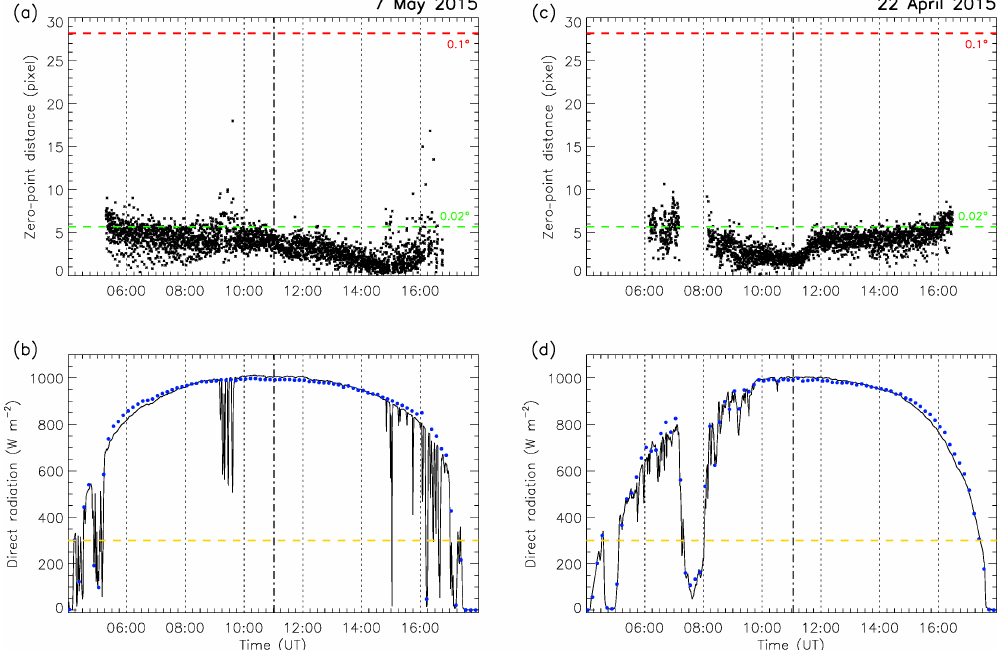
Figure 6. Performance of the Sun-tracking device at the Kanzelhöhe Observatory ARAD site for days with nearly continuous clear sky (7 May 2015, left column) and clear sky interrupted by frontal movement (22 April 2015, right column): (a) radial distance from the zero point of each valid image (asterisks); (b) direct radiation (1min averages) derived from the Kanzelhöhe Observatory ARAD site (line) and from actual Sun-sensor measurements of the Sun-tracking device (in 10min intervals, blue dots) on 7 May 2015. (c–d) As panels a–b but for 22 April 2015. Limits of active tracking (i.e., alignment within 0.02 ◦ accuracy, green line) and passive tracking (i.e., alignment within 0.1 ◦ accuracy, red line) are shown in panels a and c. The yellow dashed line in panels b and d indicates the manufacturer-specified minimum of direct radiation (300Wm − 2 ) needed for active-tracking mode. The vertical black dot–dashed line indicates the astronomical noon in all